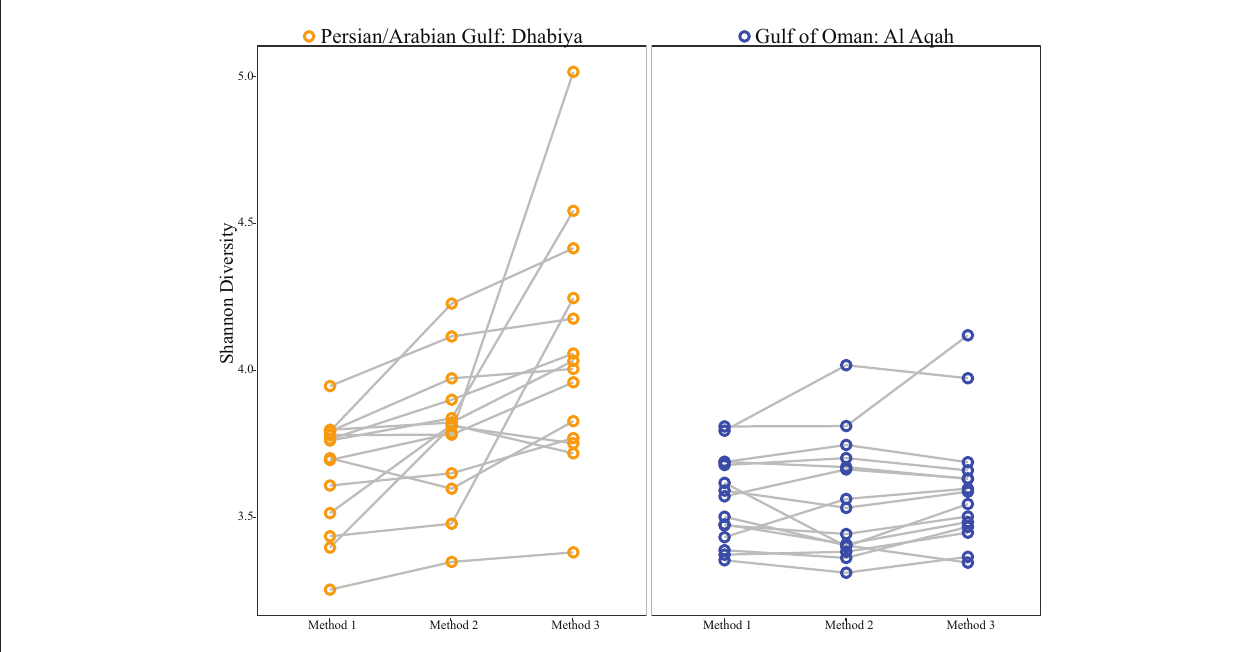
FIGURE 5 | Shannon Diversity indices of Persian/Arabian Gulf samples (left) and Gulf of Oman samples (right) . Each node corresponds to an individual sample and each line connects one individual’s tissue subjected to the three DNA extraction